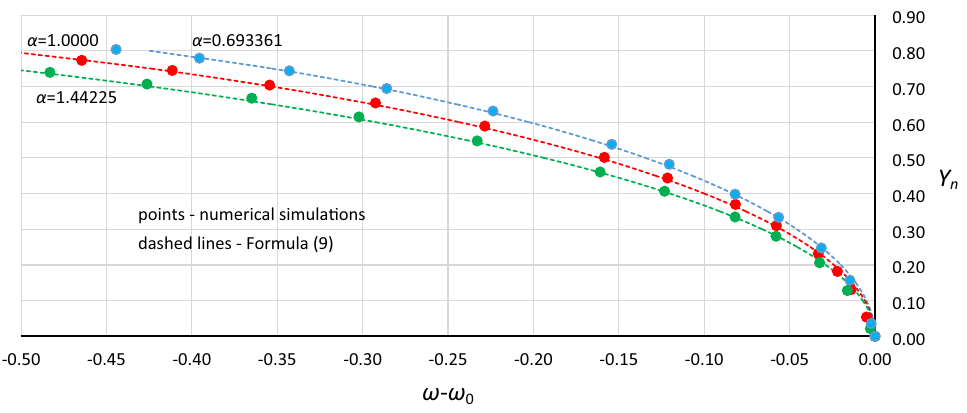
Figure 12. Relative curves of the origin point P B for α = 1.44225 (green line), α = 1.0000 (red line) and α = 0.693361 (blue line), calculated with formula (9), compared with points of P B obtained from numerical simulations and recalculated for the nondimensional value Y n .